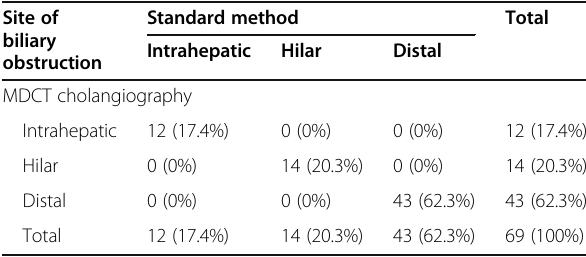
Table 5 Agreement between MDCT cholangiography and gold standard method in the detection of the site of biliary